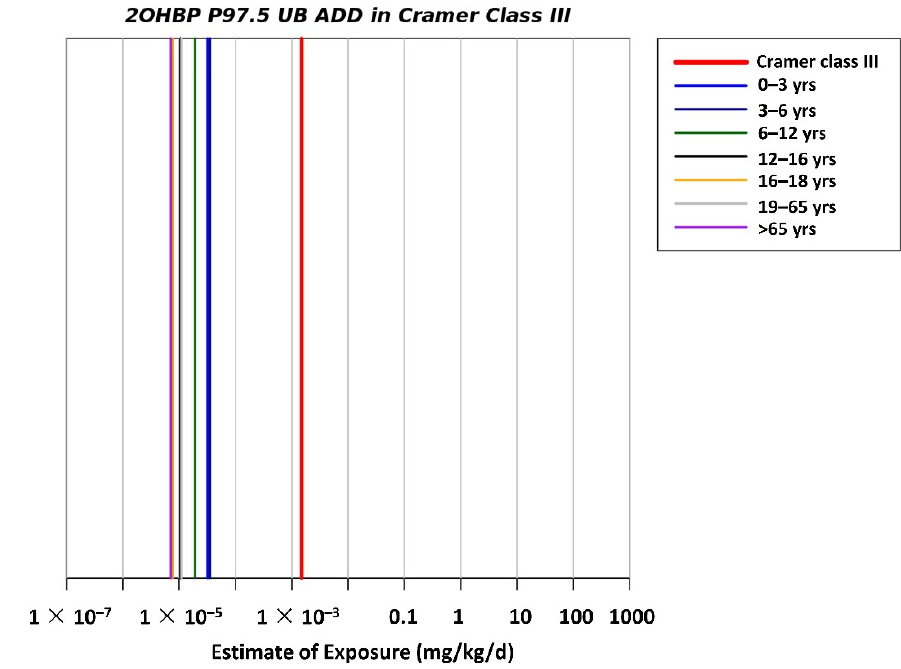
Figure 5. TTC plot of exposure to 2-OHBP in different age groups.